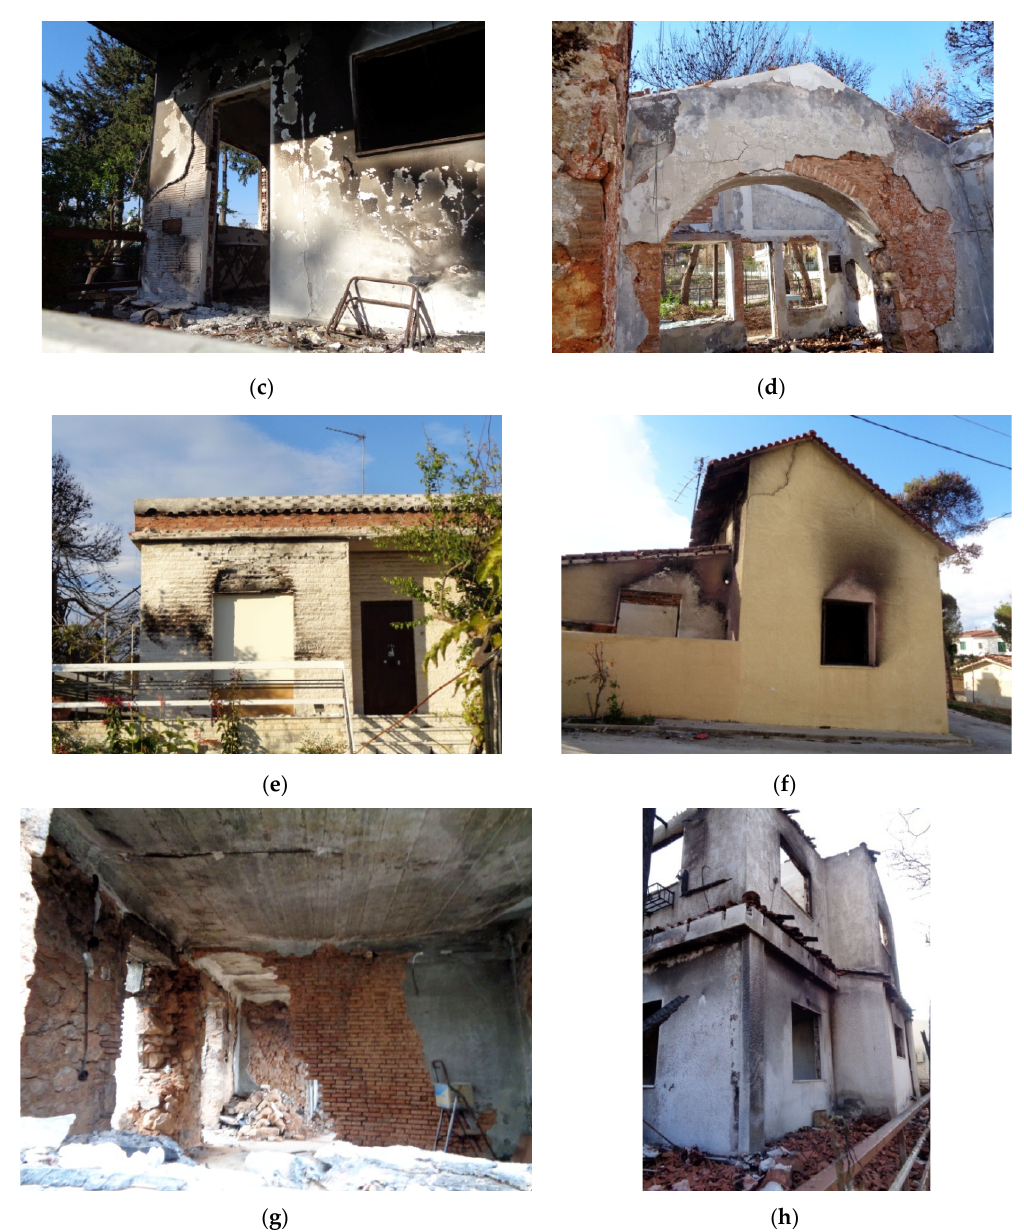
Figure 6. Photographs of damage in masonry buildings after the wildfire in Mati: ( a , b ) discoloration of exposed surfaces; ( c – f ) cracking of walls; ( g ) extensive damage; ( h ) destroyed wooden roof.